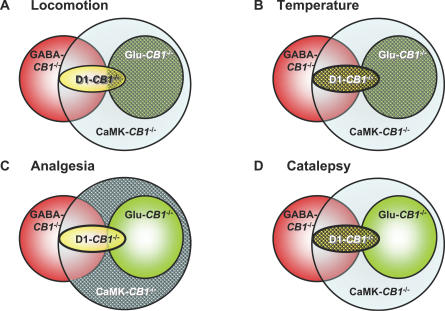
Graphic Representation of Results Obtained with Different CB1 Mouse Mutant LinesOverlapping of CB1 deletion in the different mutant lines is represented as in Figure 3. Patterned areas represent the likely regions and/or cell types where THC exert its effects on (A) locomotion (principal glutamatergic cortical neurons), (B) body temperature (principal glutamatergic cortical neurons with a possible participation of a portion of striatal MSNs), (C) pain perception (principal neurons, but not striatal MSNs nor glutamatergic cortical neurons), and (D) catalepsy (principal neurons, likely by a simultaneous stimulation of CB1 receptors on both MSNs and glutamatergic cortical neurons). Note that GABAergic interneurons (represented by the nonoverlapping portion of the red circle) never appear to be necessary for any of the observed THC effects.